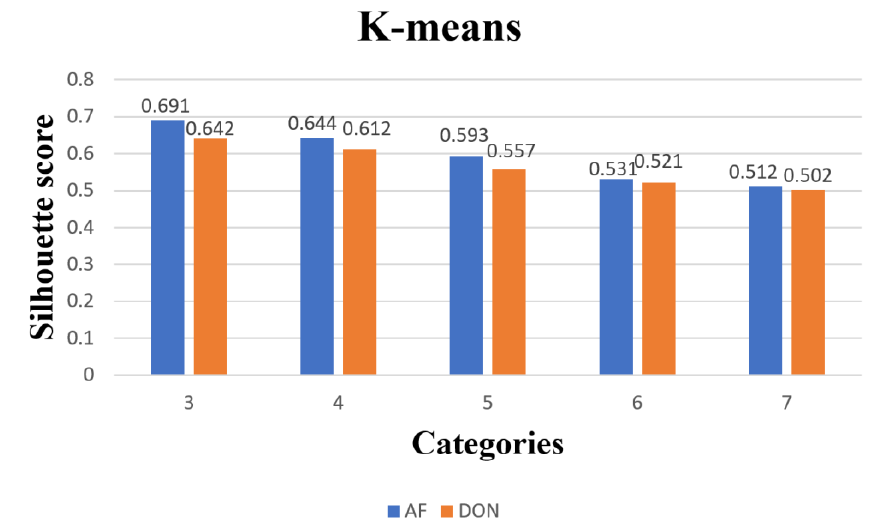
Figure 6. K-means 5 types of clustering category profile coefficients.